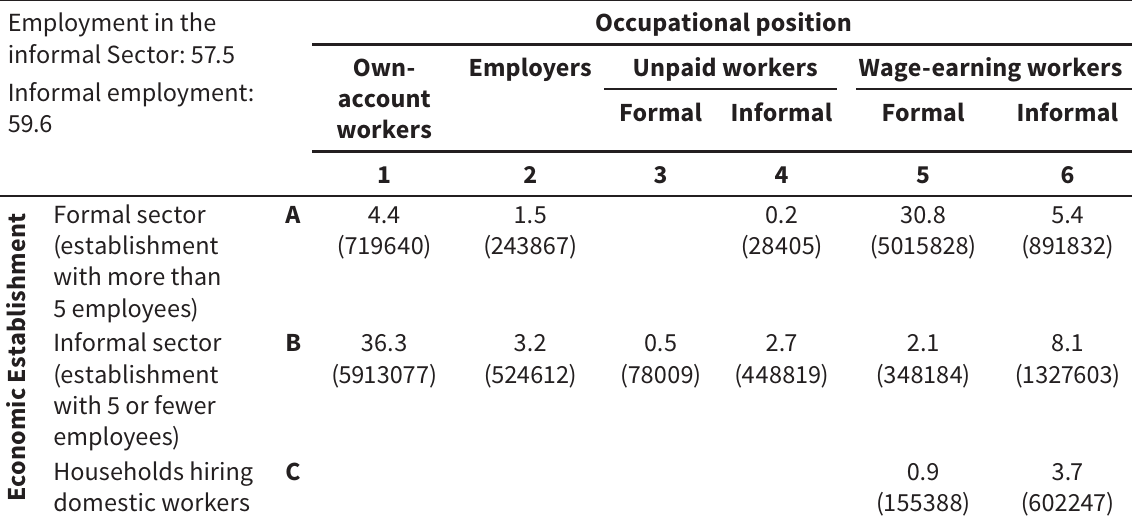
Informal employment and employment in the informal sector in Colombia, 2013 Employment in